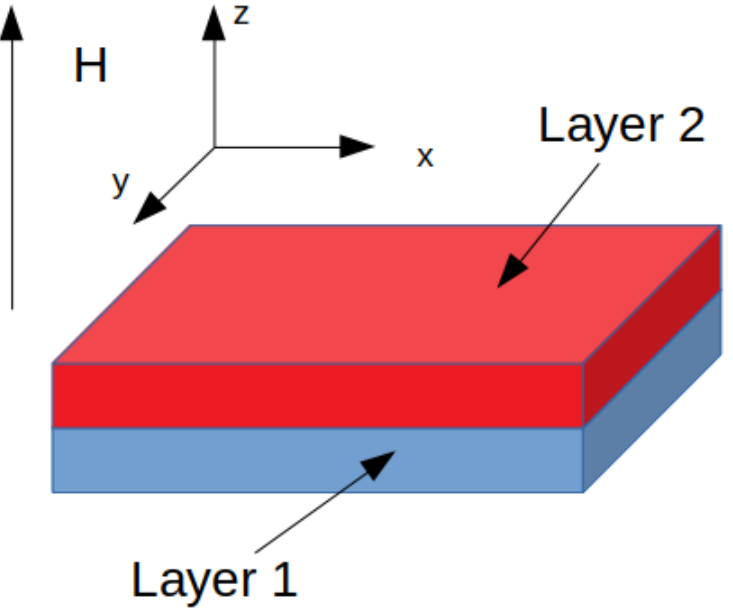
Figure 6. Image of the simulated bilayer spring-exchange system.